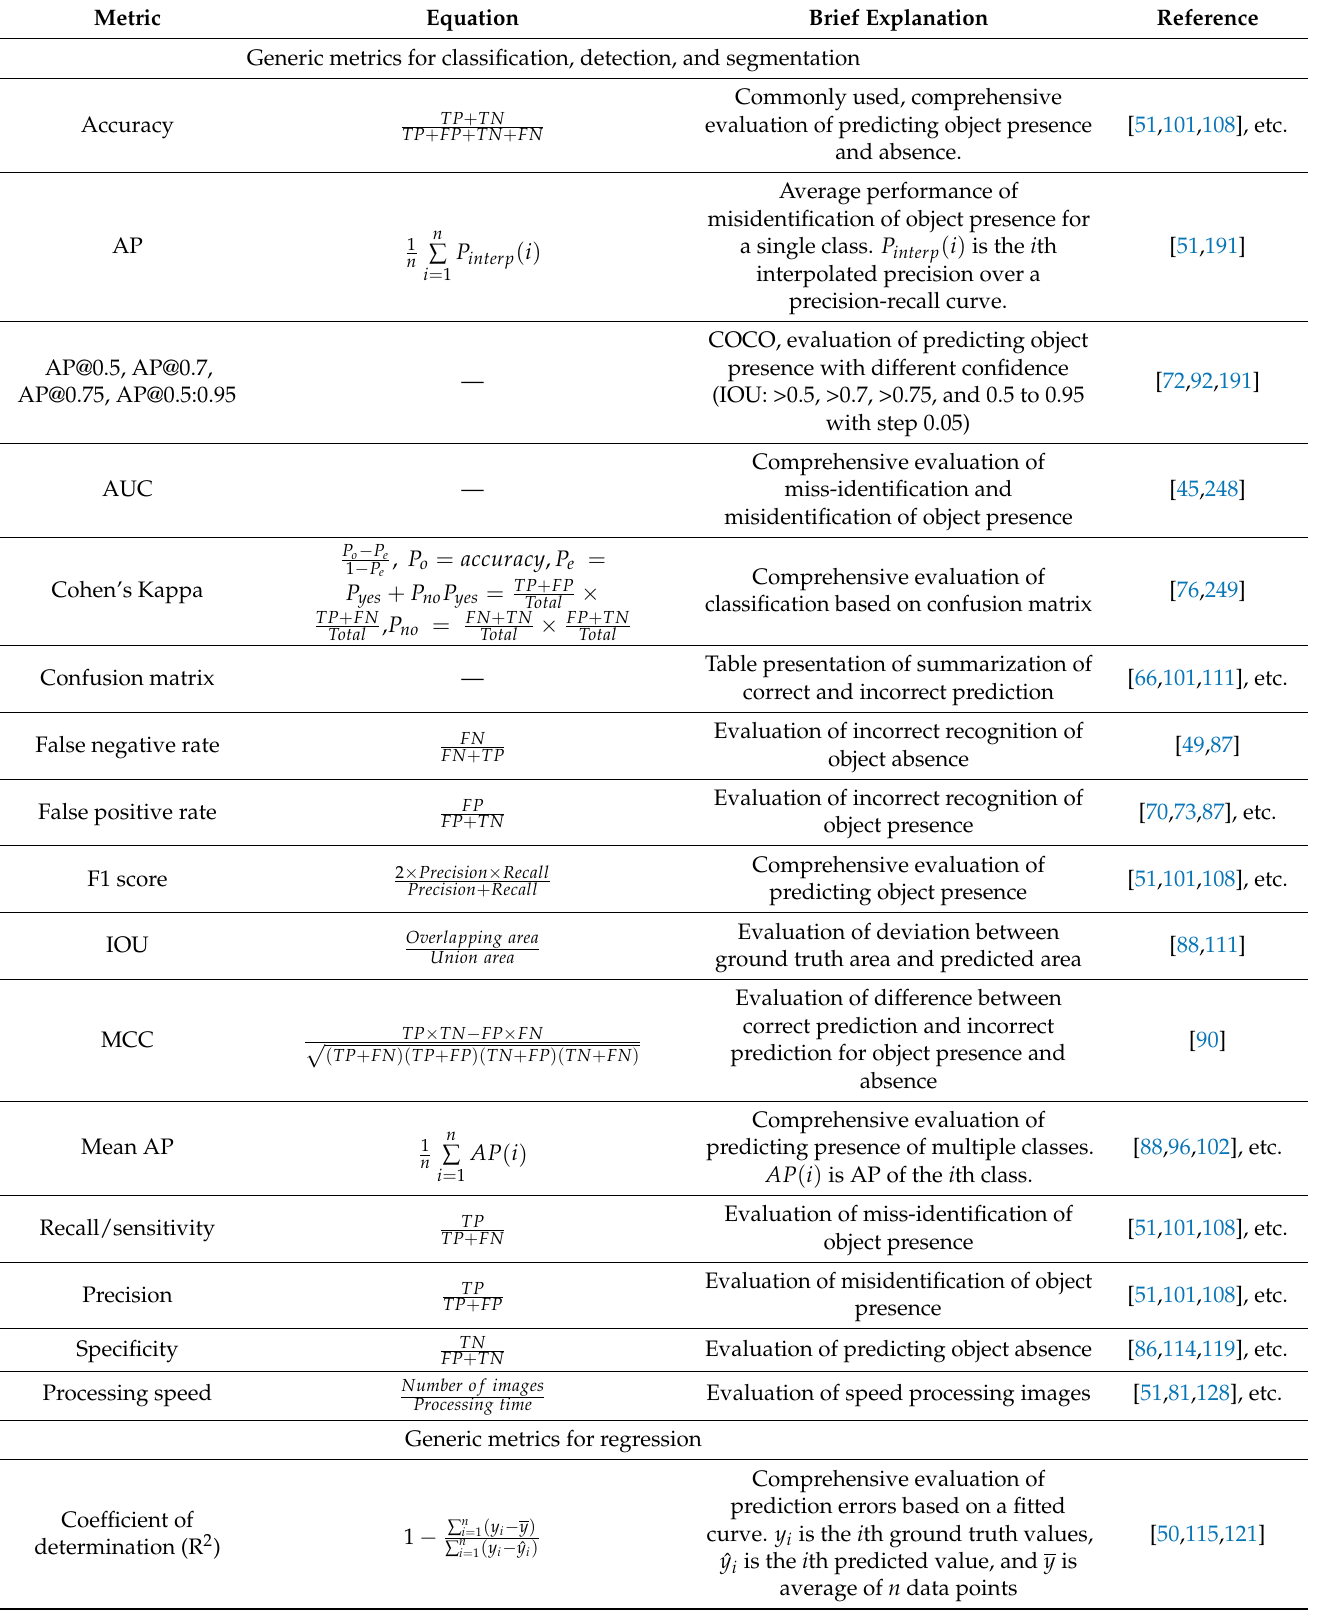
Table 8. Metrics for evaluating performance of convolutional neural network architectures. Metric Generic metrics for classification, detection, and